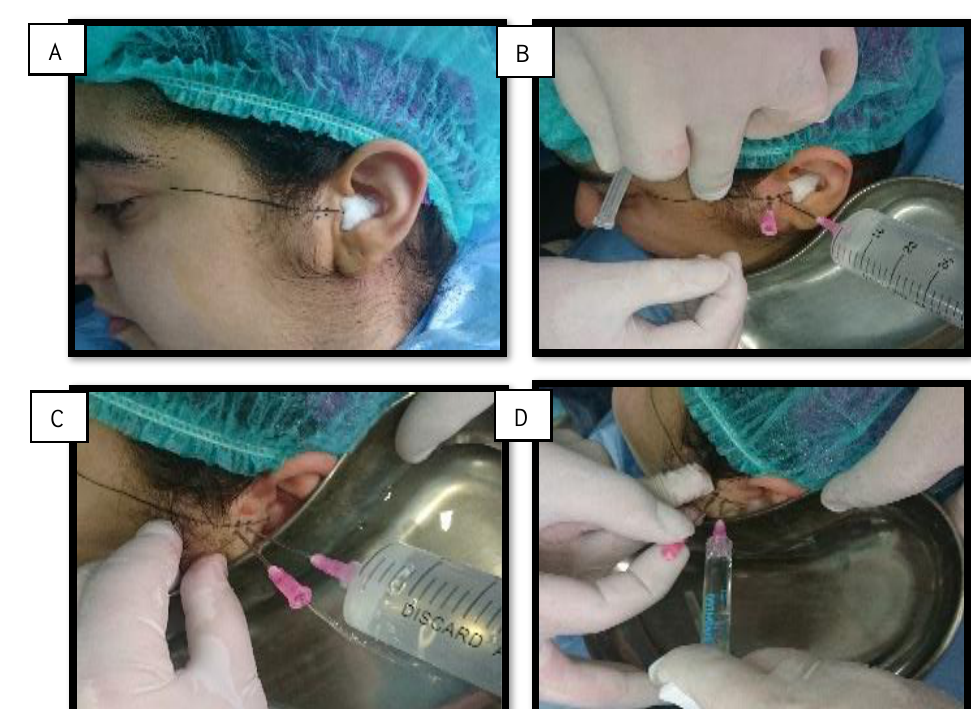
Figure 1: The manuver of arthrocentesis accompined by Hyaluronic Acid injection. (A) The drawn line from mid tragus of the ear to the lateral canthus of eye (Holmlund-Hellsing line), (B)The two needles procedure, (C)Wash with normal saline with spurt of solution from the second needle during the lavage, (D)Injection of 1 ml of